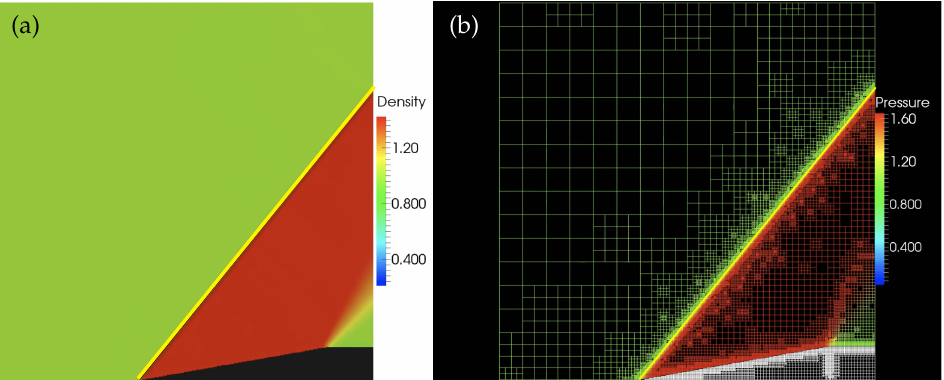
Figure 5. Supersonic flow reflecting from a wedge with the deflection angle θ = 10 ◦ , and the oblique shock angle of β ≈ 51 ◦ indicated by the yellow line: ( a ) density field, ( b ) adaptive grid colored by the pressure